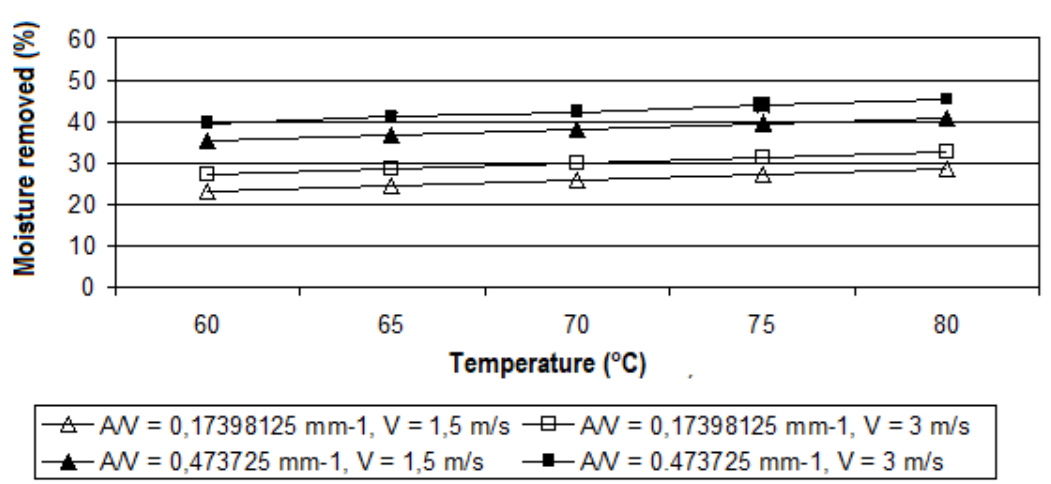
Figure 1. Relationship between moisture removed and recirculation-air control temperature for one kilogram of cassava with two levels of speed and the surface-to-volume ratio. Source: Durango and colleagues [20].